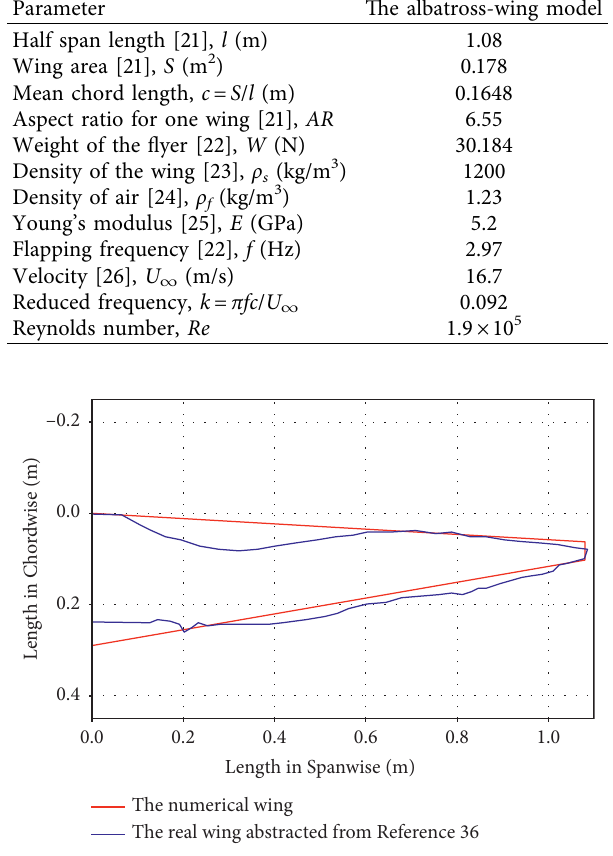
Figure 1: Layout of the numerical and natural wings.